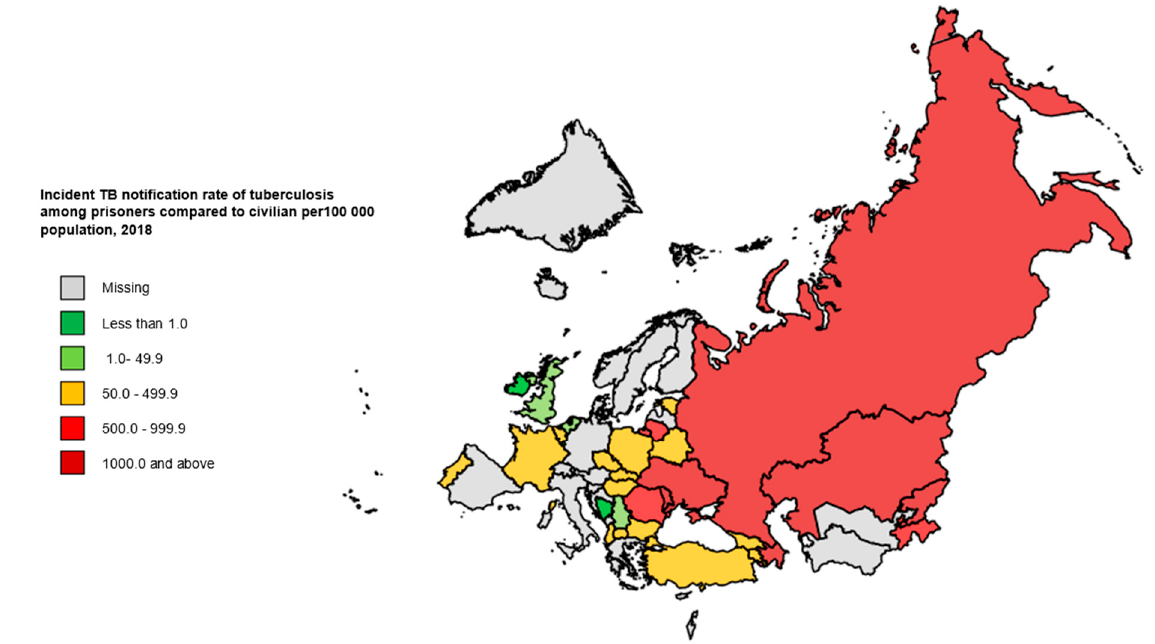
Figure 2. Notification rate of incident TB cases in the penitentiary sector per 100,000 population, WHO European Region, 2018. TB: tuberculosis; WHO: World Health Organization.